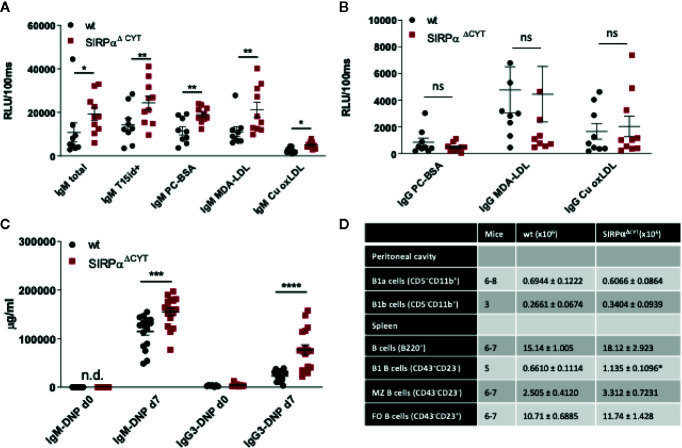
Loss of SIRPα signaling promotes B1 cell accumulation in the spleen and natural IgM antibody formation in vivo. Defective SIRPα signaling in mice lacking the SIRPα cytoplasmic tail (SIRPαΔCYT) results in increased plasma levels of natural IgM (A) but not IgG (B) antibodies directed against the indicated oxidation-specific epitopes under steady-state conditions; wt, wild-type mice; RLU/100 ms, Relative Luminescence per 100 ms. (C) Immunization with the haptenated TI-2 antigen DNP-Ficoll triggers increased production of both IgM and IgG3 antibodies against DNP in SIRPαΔCYT mice. Data are presented as mean ± SEM and are representative of 9-10 (A), 8 (B), 17 (C) individual mice. (D) B cell numbers in peritoneal cavity and spleen of wt and SIRPαΔCYT mice. Absolute number of different B cell populations was determined in the peritoneal cavity and the spleen of young adult mice (8–12 weeks) under steady state conditions. For further details see
Supplementary Figures 2A–G
. Statistical analysis was performed by unpaired Student t-test, corrected for multiple comparisons with Holm-Sedak method where applicable, *p < 0.05; **p < 0.01, ***p < 0.001, ****p < 0.0001.; ns, non-significant; n.d., not detectable.